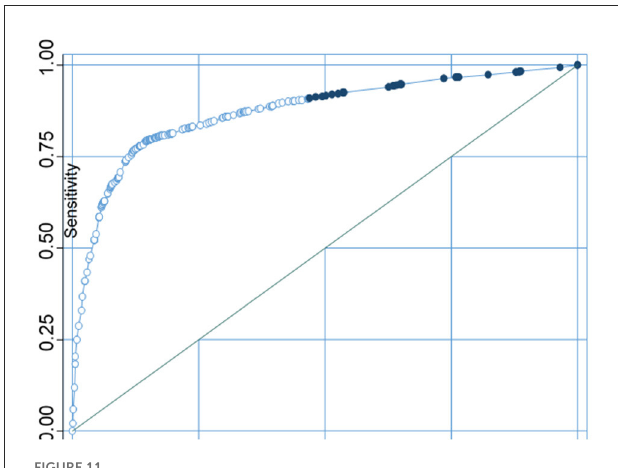
FIGURE11 Sensitivity analysis curve of sanitation facilities.